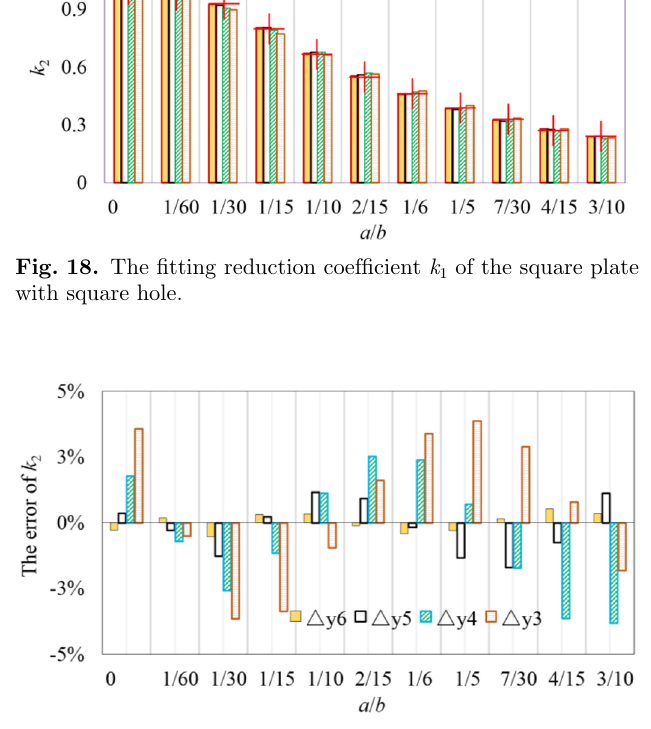
Fig. 19. The errors of the reduction coef fi cient k 2 of the square plate with square